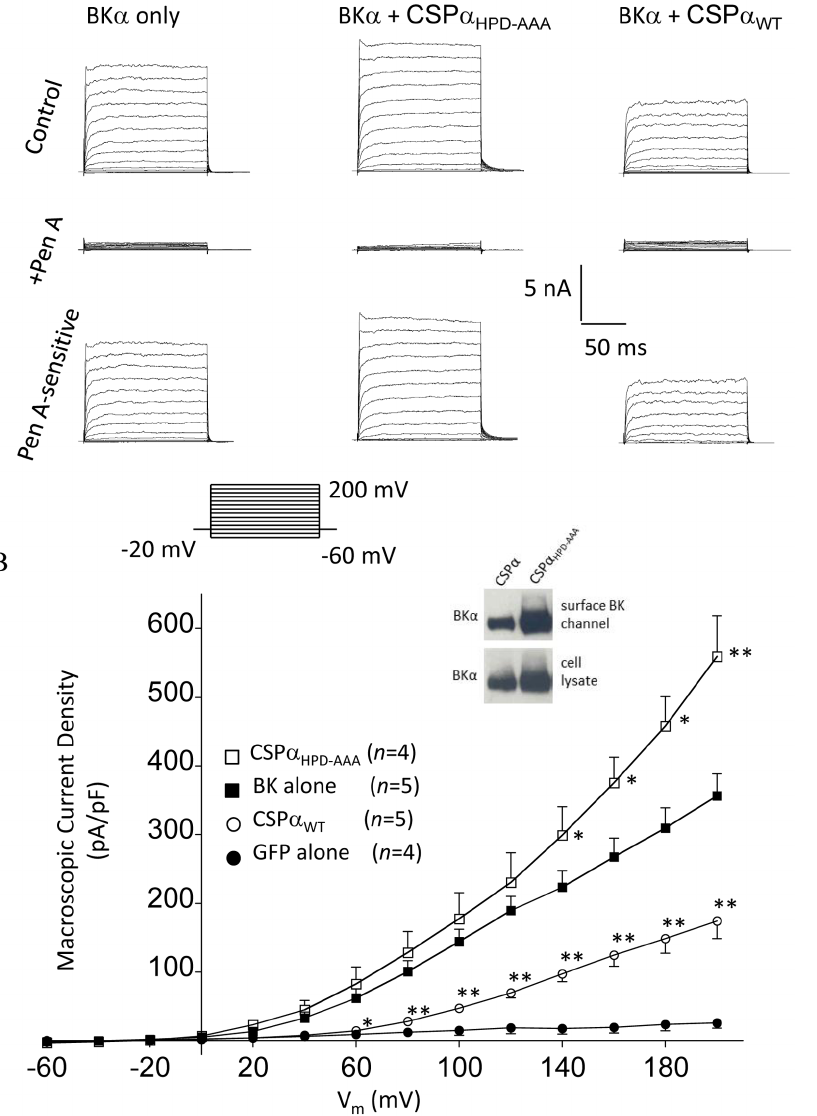
Figure 6. CSP a co-expression alters BK channel whole cell current density in transiently transfected CAD cells. (A) Representative recordings of single CAD cells voltage clamped as depicted in the protocol using the whole-cell configuration of the patch clamp technique. The left- hand column displays macroscopic BK channel currents recorded from CAD cells transiently-transfected with BK a subunits alone. The middle and right-hand columns display BK currents recorded from cells co-transfected either a CSP a mutant (i.e. CSP a HPD-AAA ) or wild-type CSP a , respectively. Recordings were done 40–48 hours post-transfection. In all three conditions, whole cell currents were largely inhibited following addition of penitrem-A (100 nM). Penitrem-A sensitive currents, obtained by digital subtraction, are displayed in the bottom row of traces. The vertical and horizontal scale bars shown apply to all current tracings. The current-voltage plot shown in panel B quantifies the average penitrem A-sensitive peak currents observed under each transfection condition and highlights the significant differences in current density magnitude found between CAD cells transiently-transfected with BK a subunits alone, and those co-transfected with either WT or a mutant form of CSP a (Dunnett post-hoc ANOVA, one- way Vs BK channel alone; *p , 0.05, **p , 0.01). Inset shows BK channel expression in CAD cells transiently co-transfected with 0.75 m g cDNA encoding either CSP a or CSP a HPD-AAA. For detection of surface expressed BK channel, transfected CAD cells were labeled for 30 min at 4 u C with bath applied Biotin, as described in the methods. Following lysis, 1 mg of soluble protein lysate was subjected to overnight streptavidin pull-down at 4 u C. Proteins isolated by streptavidin pull down (top panel) and 30 m g of soluble cellular lysate (bottom panel) were analyzed by Western Blot with an anti-BK a subunit antibody. Data is representative of 3 similar